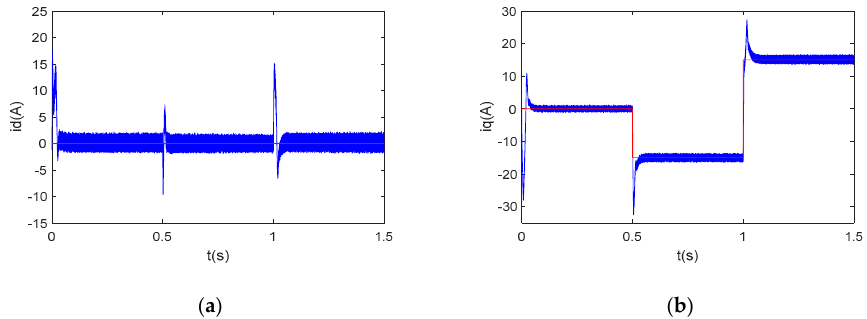
Figure 8. d-q axis current waveform of the conventional current controller without decoupling at 12,000 rpm. ( a ) d-axis current; ( b ) q-axis current.